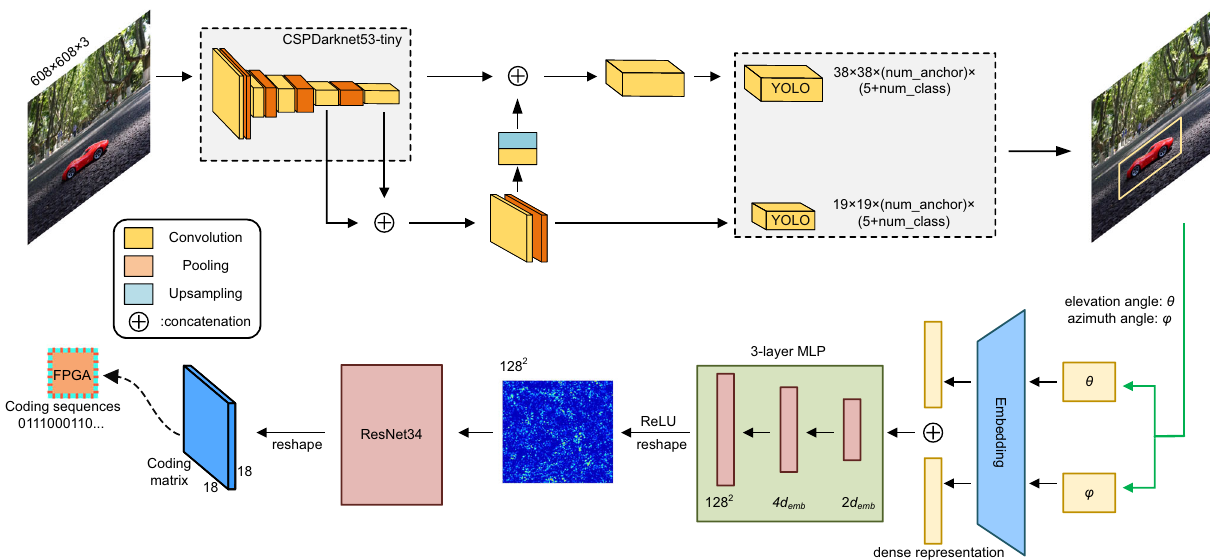
Fig.4|StructurediagramsoftheYOLOv4-tinynetworkandpre-trainedANN. In the application scenarios of this article, the location of the target needs to be obtainedbytheRS-Camera,and thepixelcoordinatesand thelabelofthe targetin theimageneedtobedetermined fi rst.Theinputimageisfedtoanetworkbasedon YOLOv4-tiny for feature extraction and target tracking. The detected target